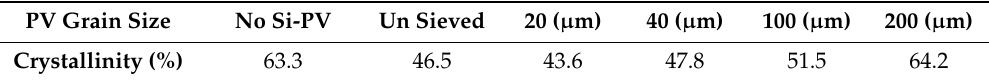
Table 4. XRD pattern of Si-PV polymer composites with different Si-PV grain size.